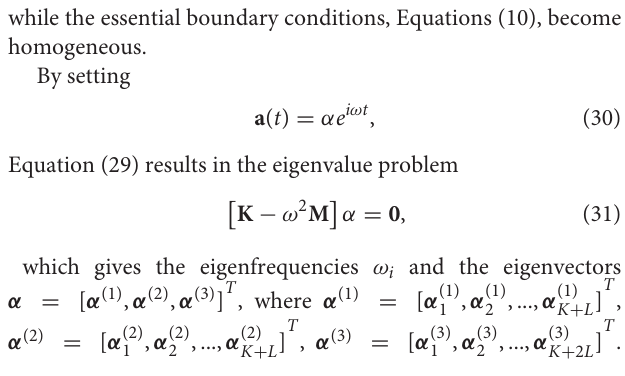
The elements of these vectors are the three sets of coefficients corresponding to the functions u , ν , and w ,